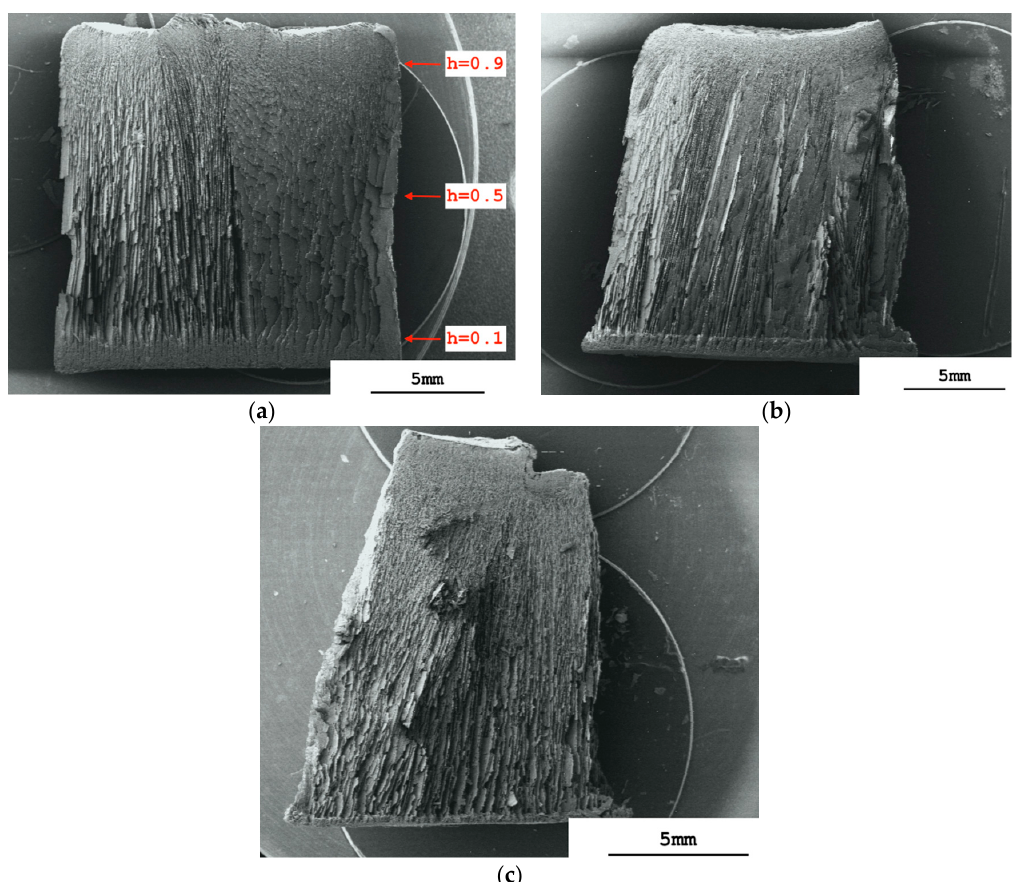
Figure 1. Scanning electron micrographs of longitudinal sectioned sintered monoliths prepared from alumina slurries having different volume fractions of dispersed phase, φ v . ( a ) φ v = 0.128; ( b ) φ v = 0.064; ( c ) φ v = 0.032. Note that the red arrows demark the planes of the cross-sections examined later by µ-CT; h = positional height within monolith (0 ≤ h ≤ 1).